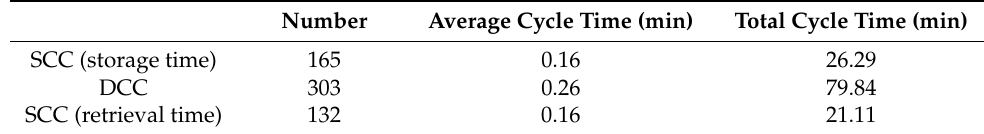
Table 4. Final results after considering storage reallocation.